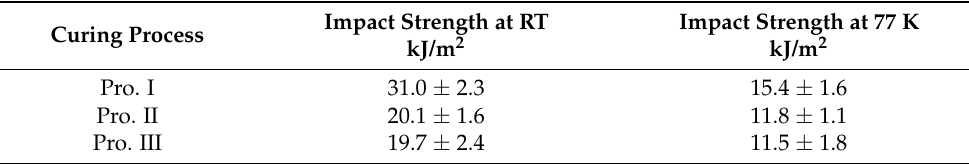
Table 2. Impact strengths of epoxy resins with three curing